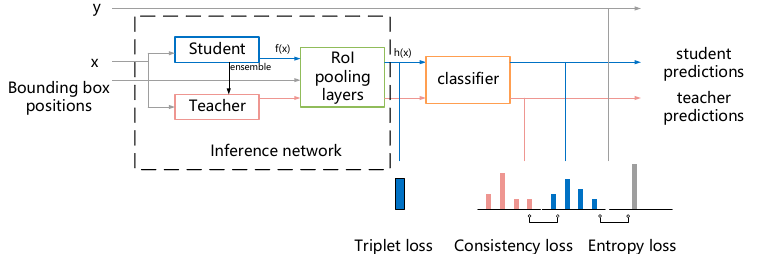
Figure 5. Overview of the entire model structure. The student model and teacher model have the same network architecture while the parameter values like weights and biases are di ff erent. Parameter values of student model are updated at the end of each training iteration and those of the teacher model are obtained by ensembling the student model. What triplet loss does is minimize the feature distances between input with the same labels while maximizing the feature distances of input with di ff erent labels. For the unlabeled samples, labels needed for computing triplet loss are from the teacher model’s predictions.